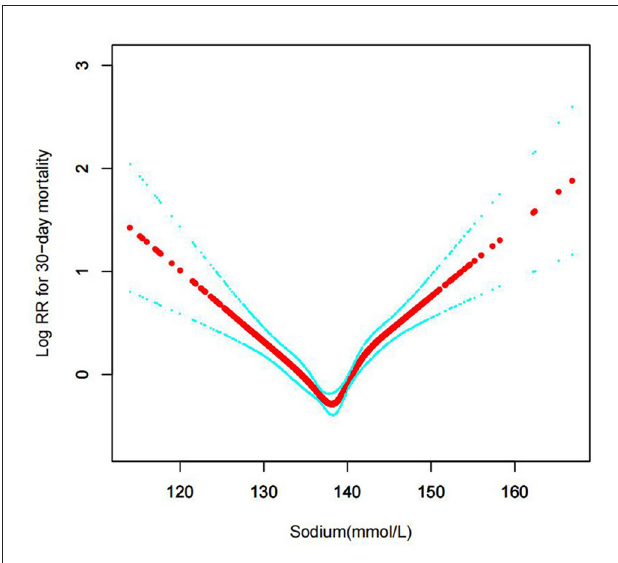
FIGURE5 Association between serum sodium levels and 365-day all-cause mortality (Unadjusted model).